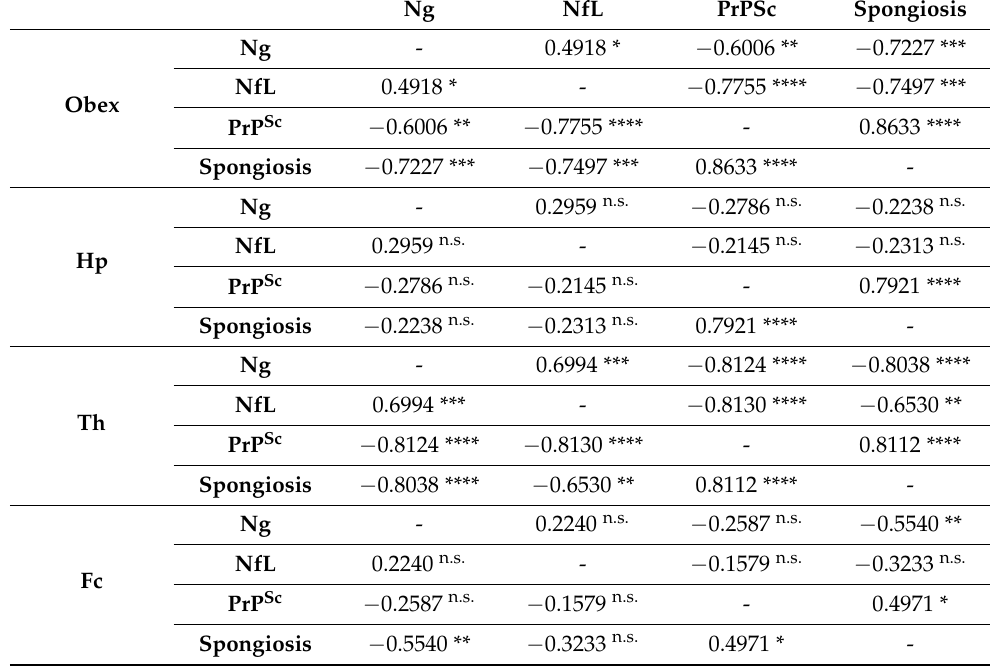
Table 1. Spearman’s correlation values between scores of Ng and NfL expression and prion-associated histopathological lesions in different brain